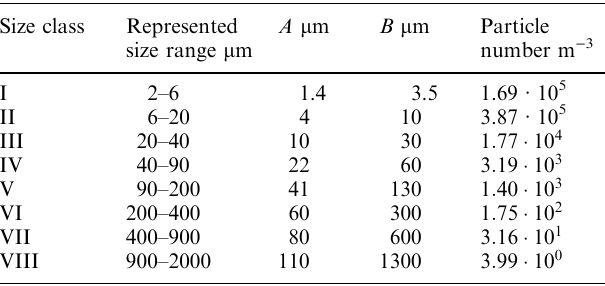
Table 1. Modelled size distribution of cirrus cloud particles. The particle concentration is 0.58 cm ) 3 , the ice water content 2.077 (cid:225)